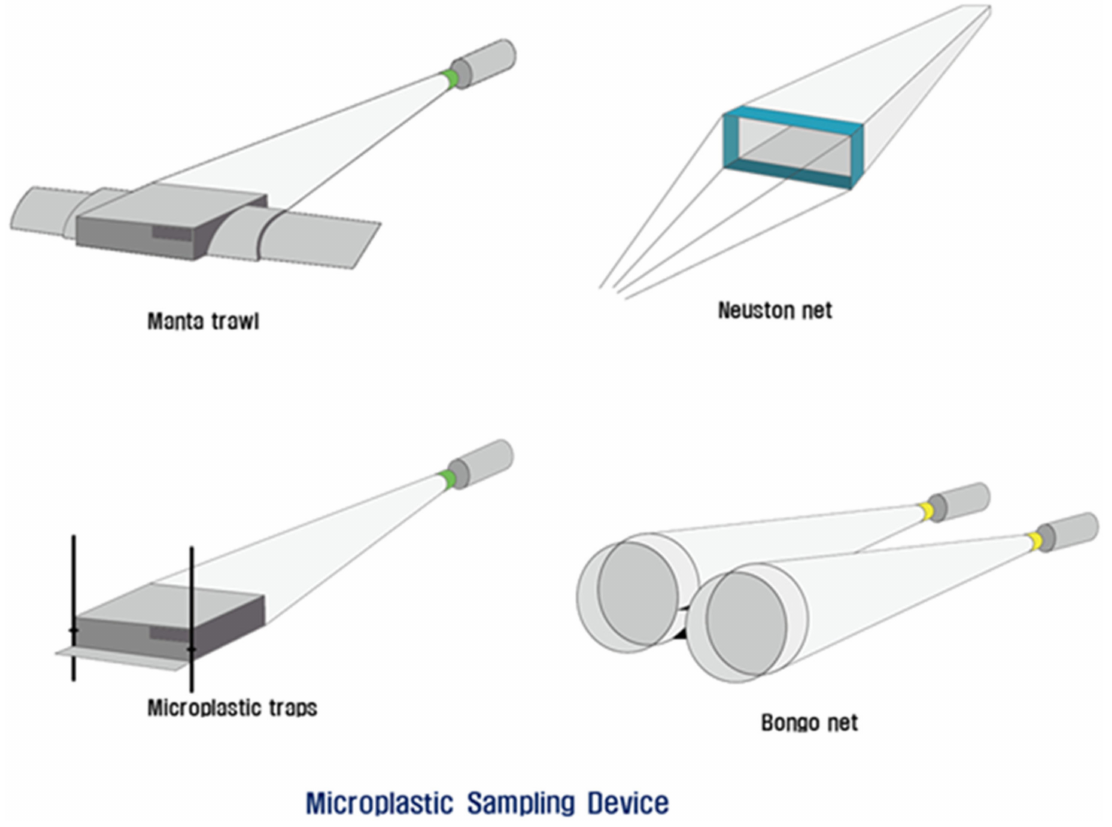
Figure 5. Types of microplastic sampling device for